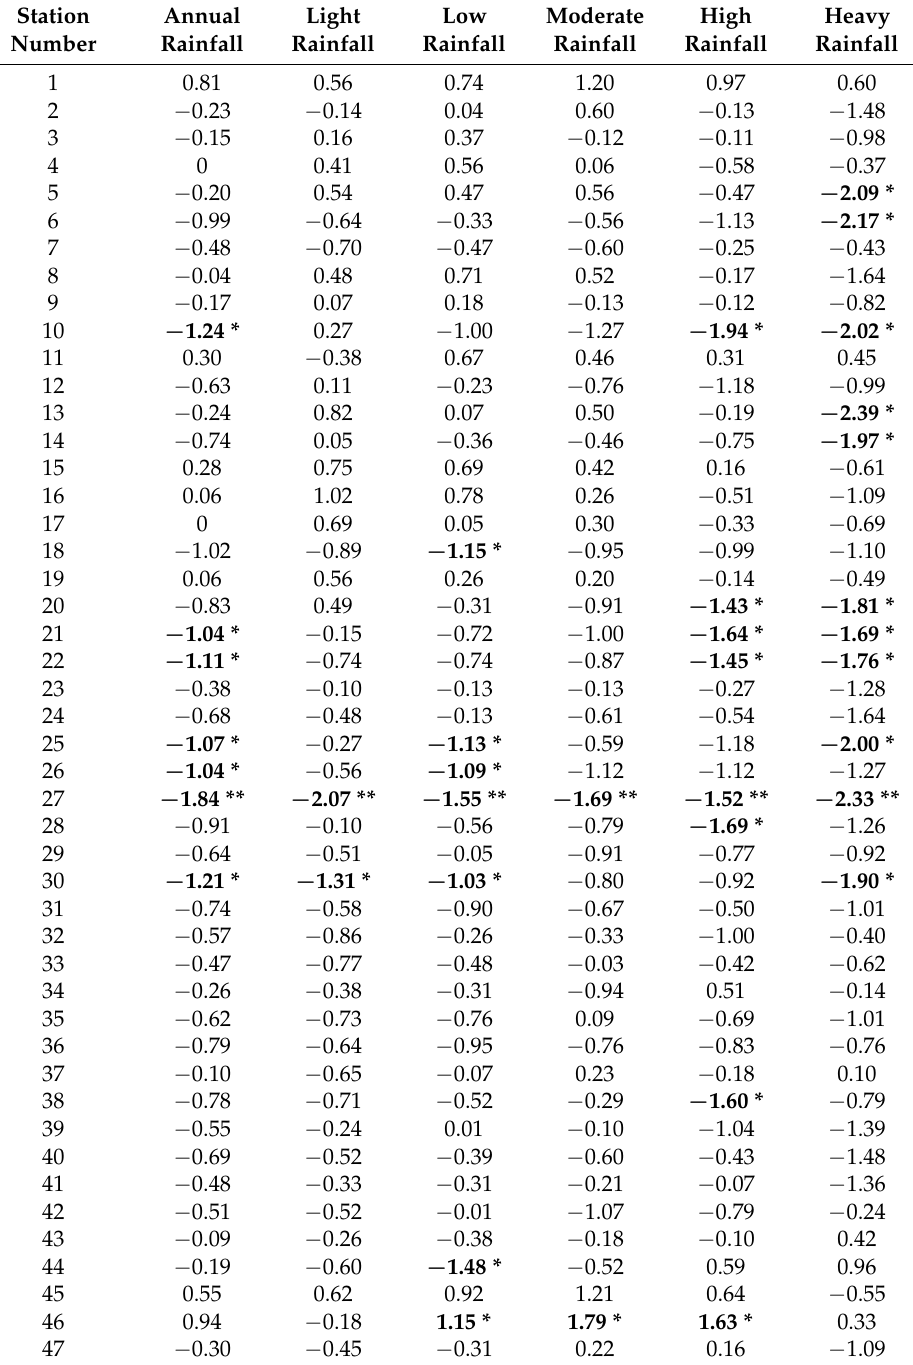
Table 2. Changes in annual rainfall according to the PTM index for annual rainfall and rainfall in different intensities, including light, low, moderate, high and heavy